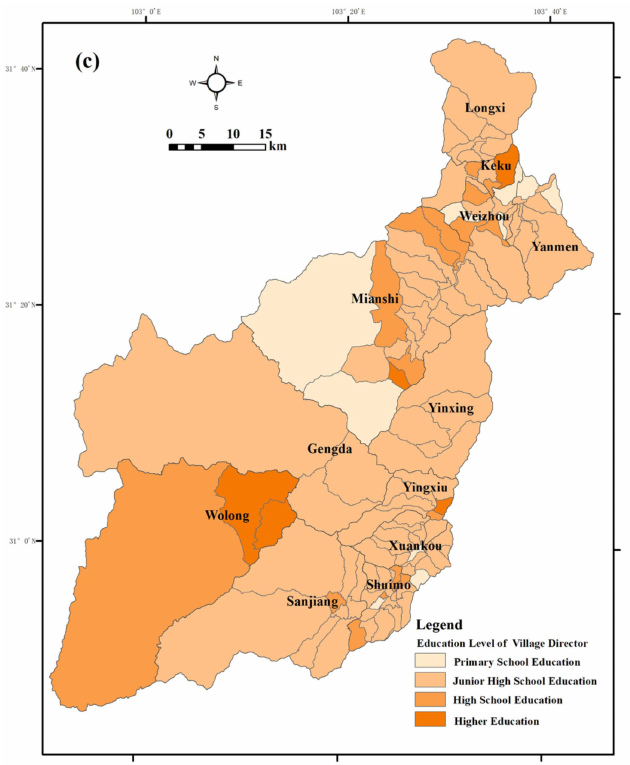
Figure 6. The spatial distribution of three restrictive factors of IERSE in Wenchuan County; ( a ) RSEI; ( b ) education level of village Party secretary; ( c ) education level of village